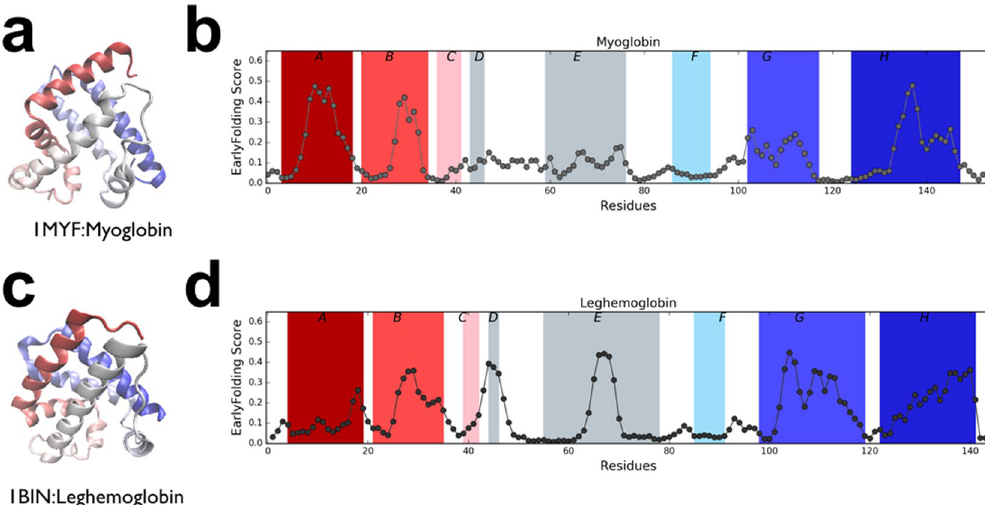
Figure 1. Myoglobin and leghemoglobin in relation to early folding scores. Myoglobin (PDB: 1MYF) ( a ) cartoon representation with helices colored from of N to C terminal and ( b ) full per-residue EFoldMine prediction, with helix regions (A–H) indicated with colors as in a. Leghemoglobin (PDB:1BIN) ( c ) cartoon representation with helices colored from of N to C terminal and ( b ) full per-residue EFoldMine prediction, with helix regions (A–H) indicated with colors as in ( c